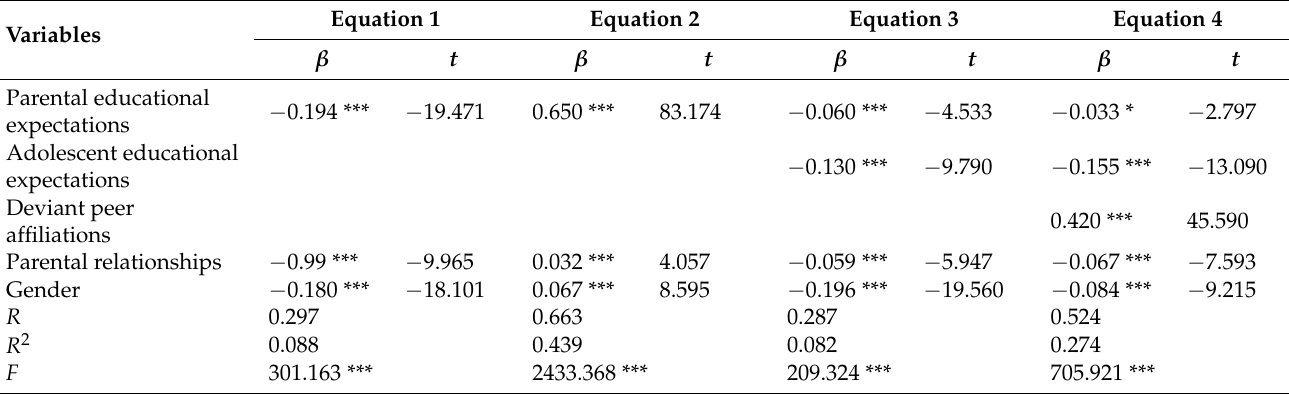
Table 2. Regression